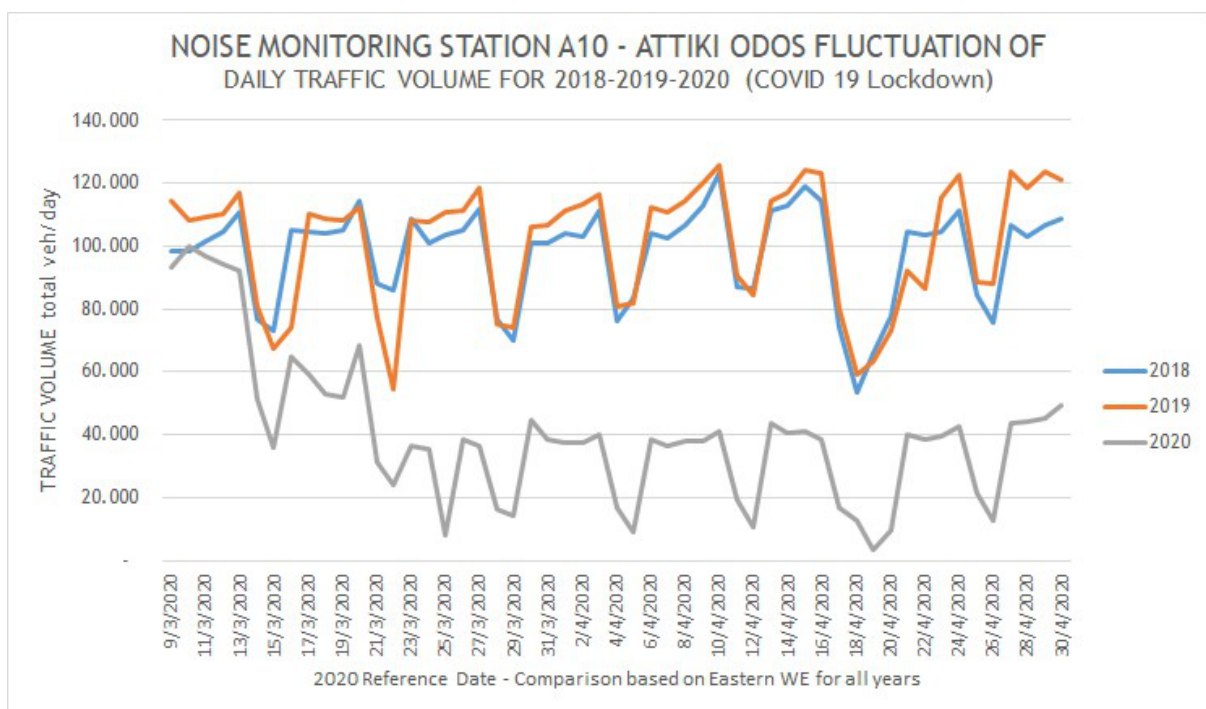
Figure 8d: Daily traflc volume – Noise monitoring station